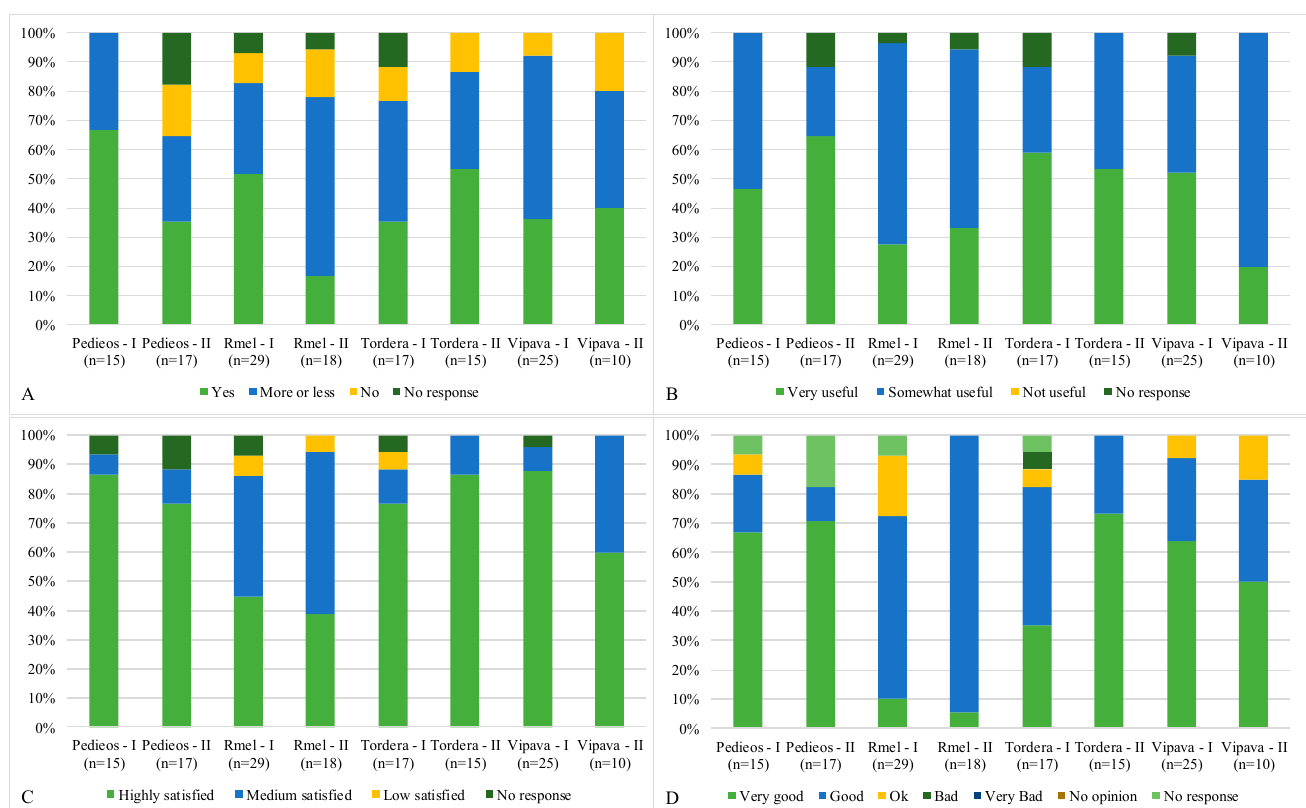
Figure 3. Response to evaluation questions: ( A ) Do you believe that basin stakeholders have the necessary knowledge and the skills to influence local policies in issues regarding climate change and adaptation?; ( B ) Do you think that your involvement in the process of developing climate change adaptation plans is useful?; ( C ) Are you satisfied how this workshop included your opinions and views?; and ( D ) How do you rate the workshop in general? Responses are shown per basin for Stakeholder workshops I and II separately.